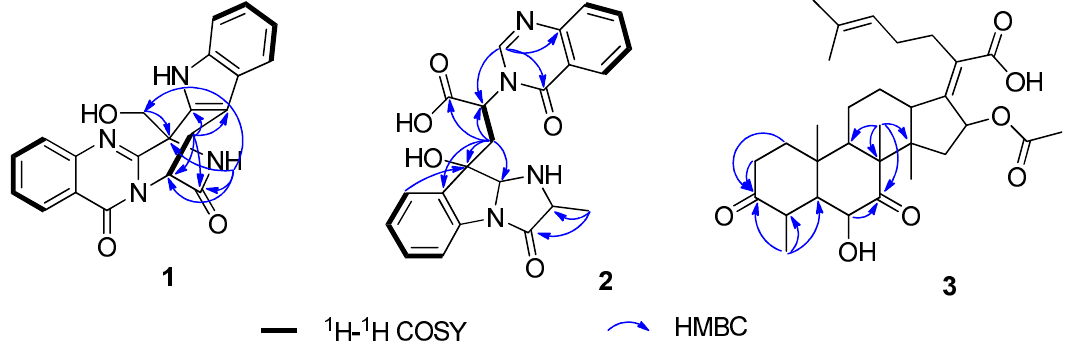
Figure 2. Key HMBC and 1 H- 1 H homonuclear correlated spectroscopy (COSY) correlations of compounds 1 and 2.